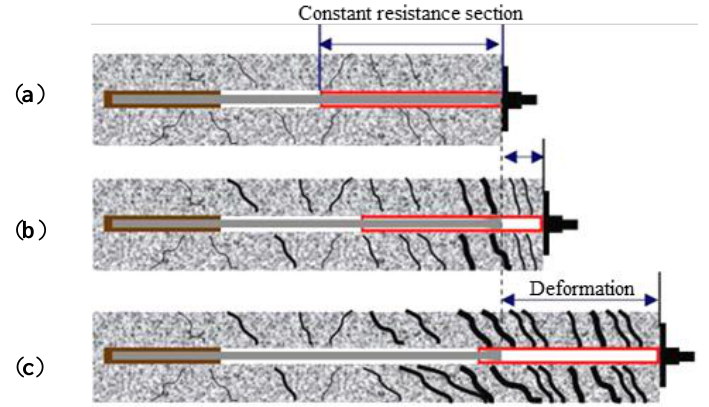
Figure 4. Principle of the constant resistance anchor cable: ( a ) Before deformation of surrounding rock; ( b ) Under deformation of surrounding rock; ( c ) After deformation of surrounding rock.